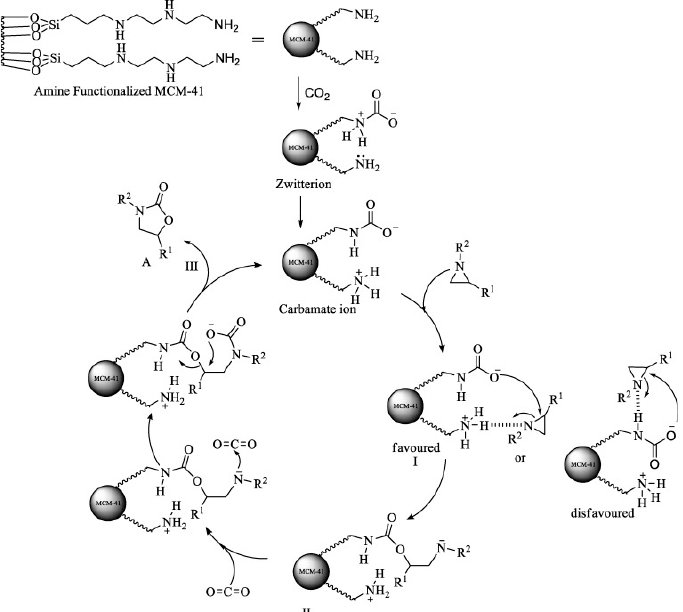
Figure 6 . Proposed plausible catalytic reaction pathway. Reproduced with permission from [9].